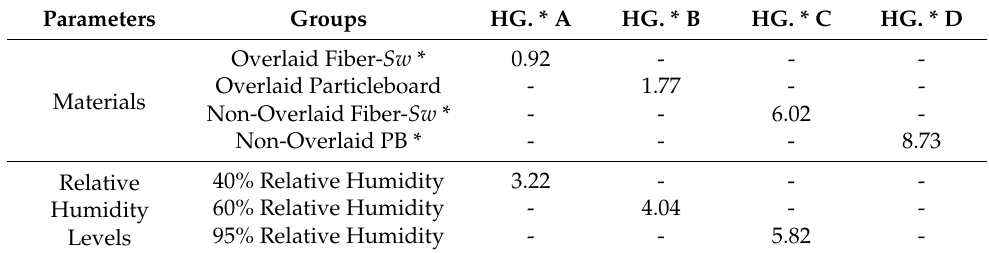
Table 4. Comparative test results for the effect of relative humidity level on various properties of the composite panel samples for homogeneity groups.